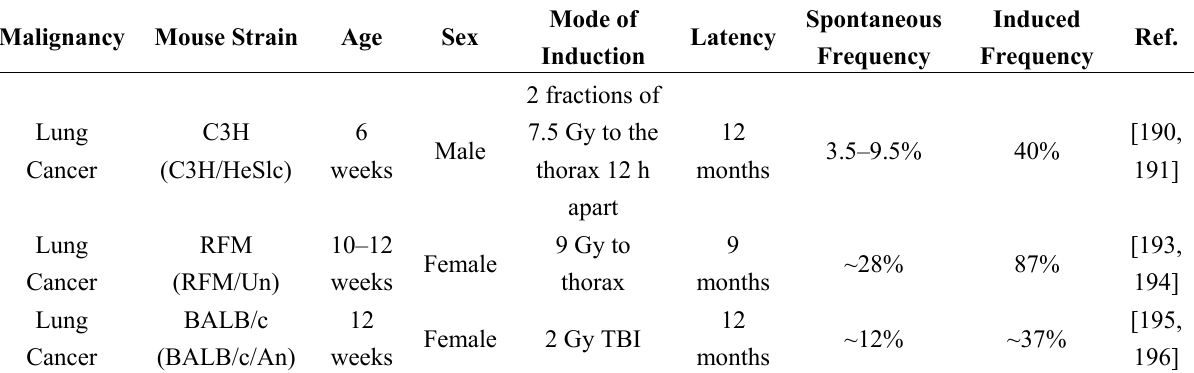
Table 4. Induction of lung cancer in mice with low-LET ionizing